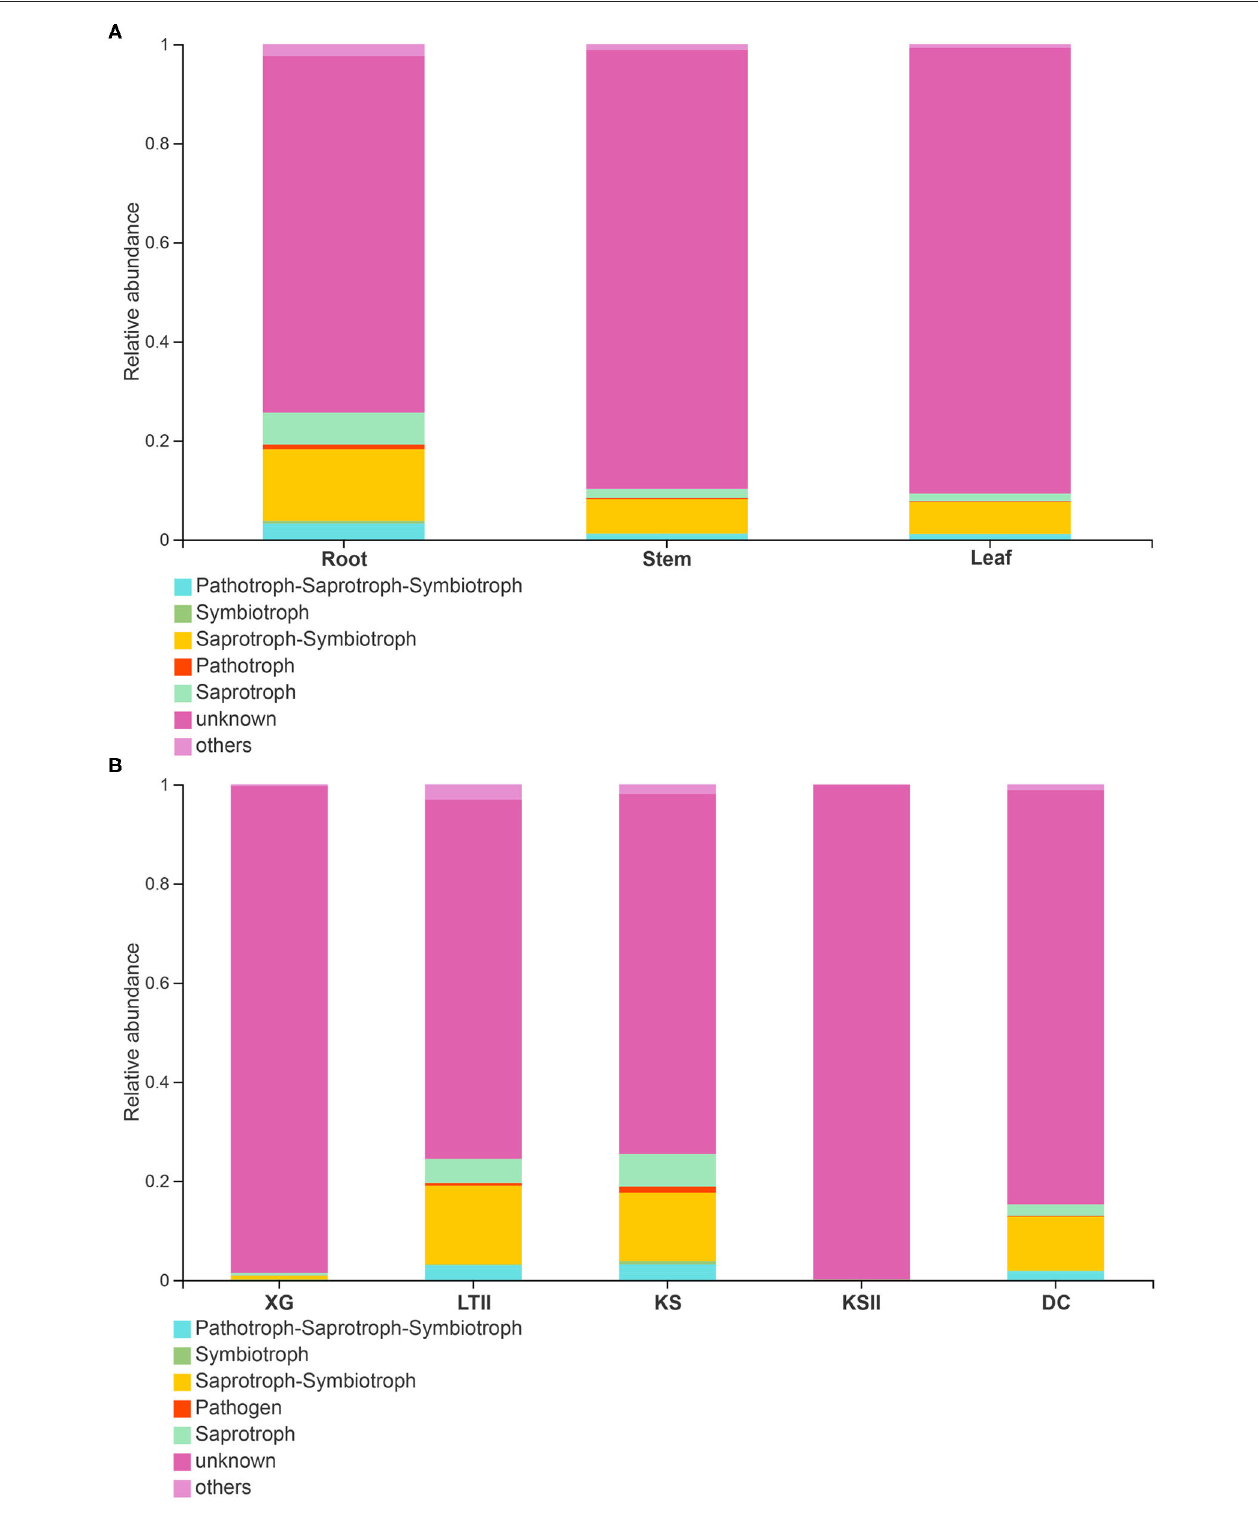
FIGURE 6 | Relative abundance of fungal functional groups (guilds) based on OTUs. (A) display the relative abundance in different tissues of Batrachium bungei . (B) display the relative abundance of B. bungei in different sampling sites. When the relative abundance < 0.005% will merges into others.